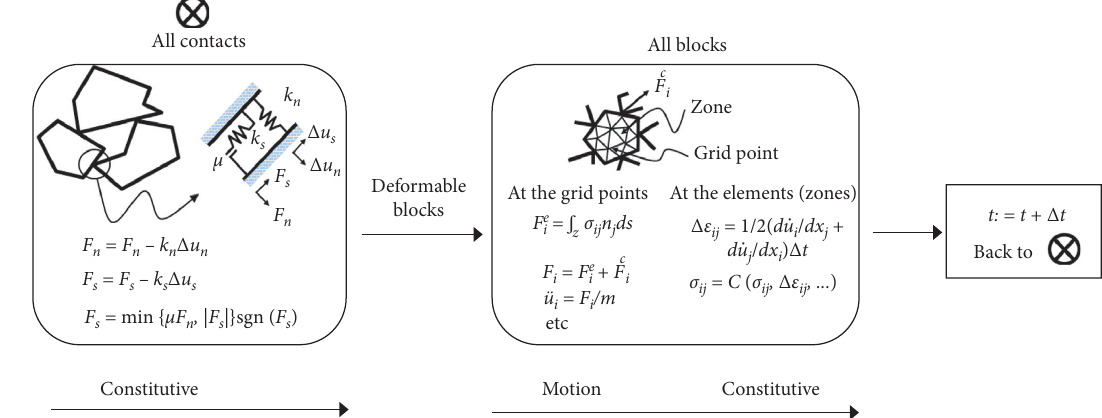
Figure 1: Schematic diagram of the proposed 3DEC model. Table 1: Elastic block and contact mechanical properties used in the model.